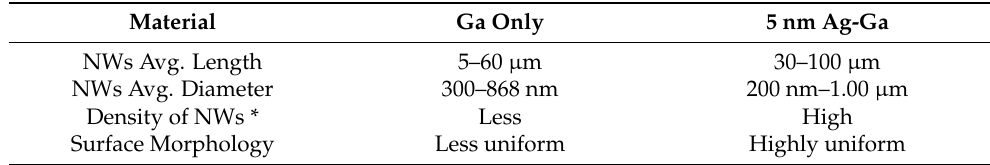
Figure 3. Side views of SEM images of Ga 2 O 3 nanowire grown at 1000 °C. ( a ) Free-Ag of Ga 2 O 3 nanowires on a quartz substrate. ( b ) Ga 2 O 3 nanowires on quartz catalyzed by 5 nm Ag. Longer and denser Ga 2 O 3 nanowires were attained in the presence of Ag. Table 1. Summary of data that highlight the main differences between Ga 2 O 3 nanowires on quartz without and with 5 nm Ag catalyst.